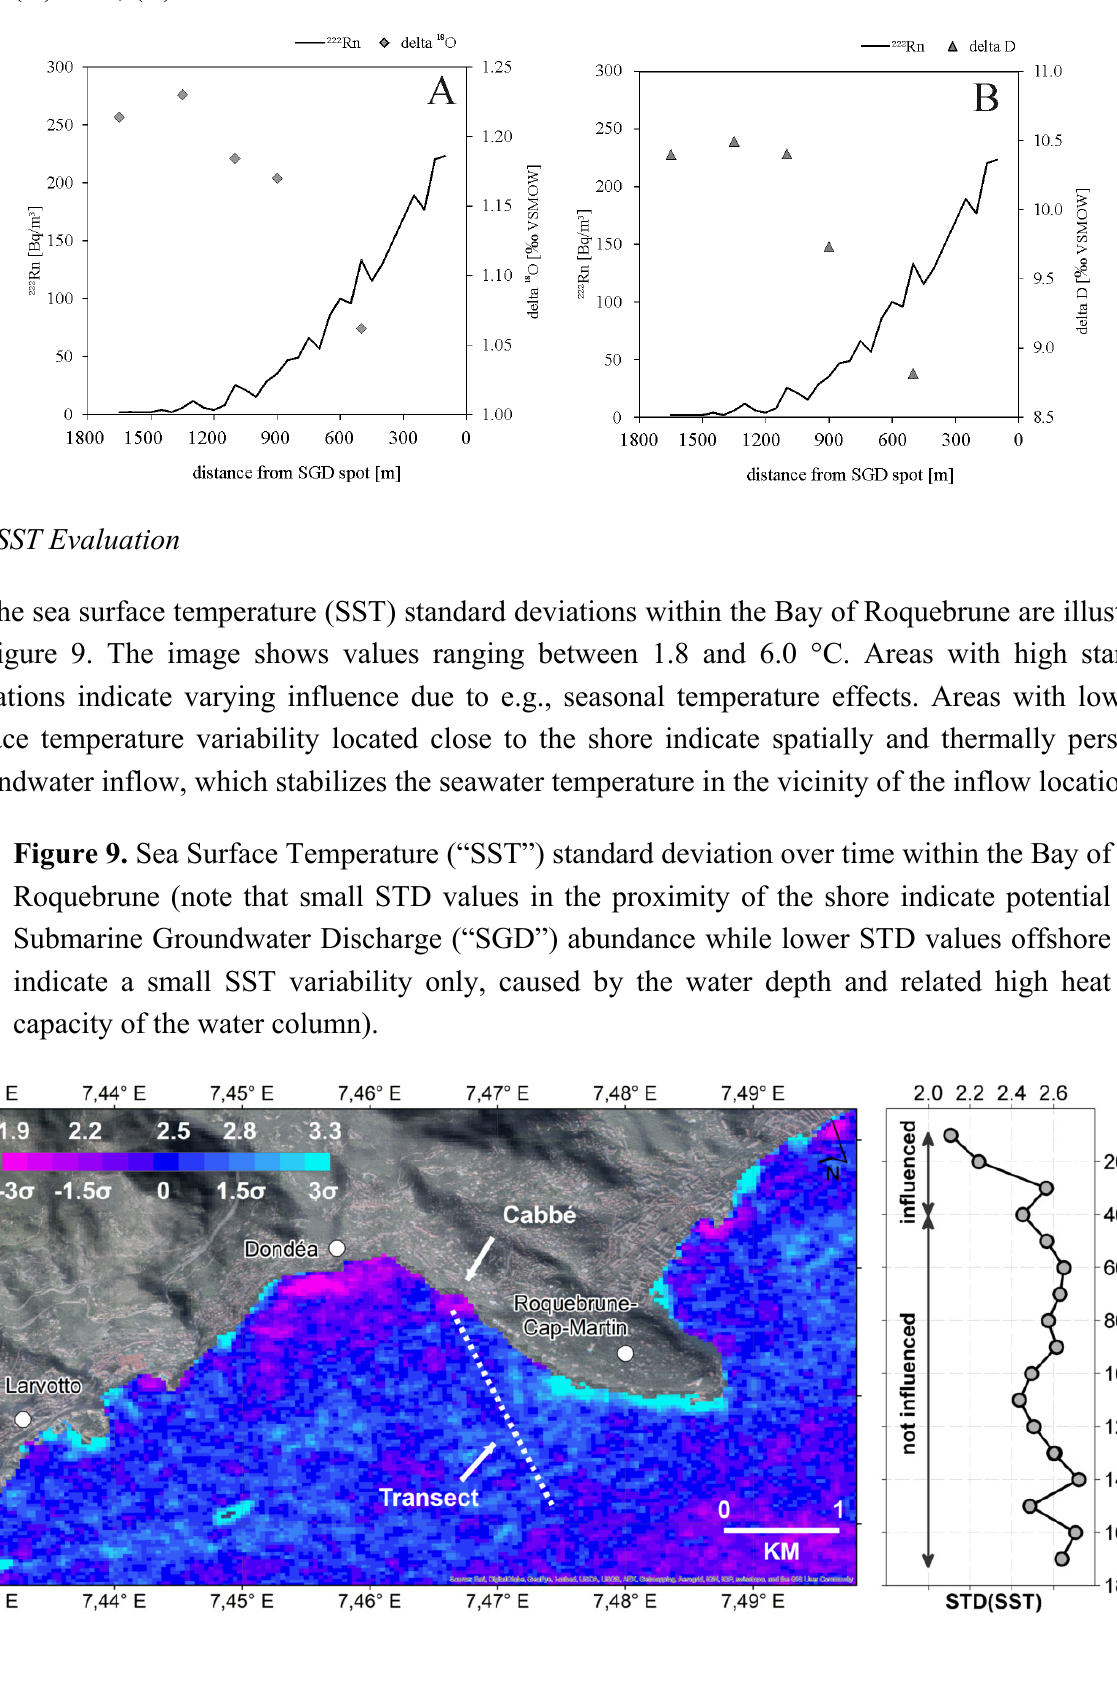
Figure 8. Radon concentrations and water stable isotope signatures along the transect; ( A ) δ 18 O; ( B ) δ 2